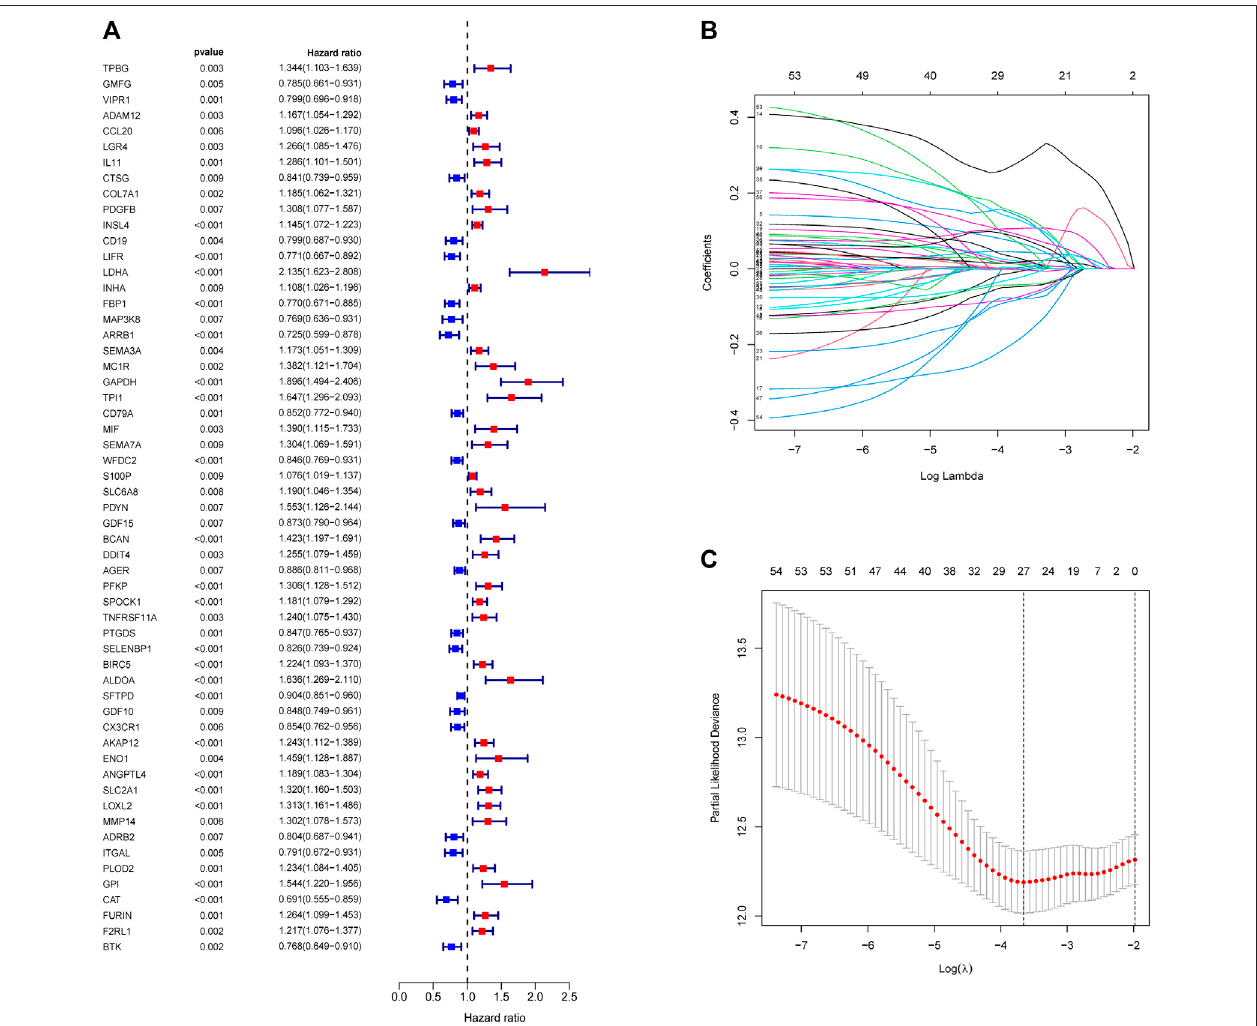
FIGURE 5 | Construction of risk score formula. (A) Forest plots showing the results of survival related gene via univariate Cox regression analysis between interacted genes and OS. (B) LASSO coef fi cient pro fi le plots of the 57 prognostic related genes showing that the variations in the size of the coef fi cients of parameters shrink with an increasing value of the k penalty. (C) Penalty plot for the LASSO model for the 57 prognostic genes with error bars denoting the standard errors.